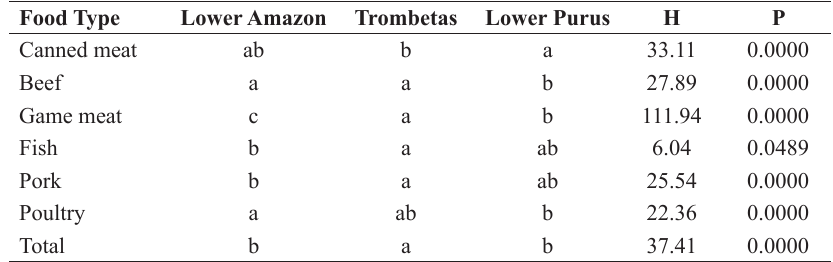
Results of the Kruskal Wallis and multiple comparison tests for the analysis of food consumption rates among the study areas. Different letters indicates significant differences (α = 0.05), where a>b>c. Differences that were not significant are not presented